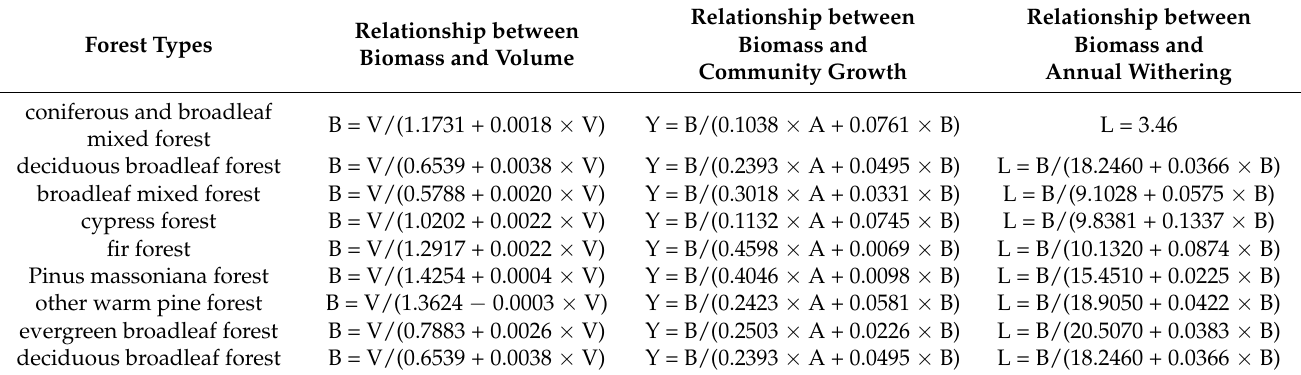
Table 2. Relationship between forest volume, biomass, and NPP of typical tree species (excerpt)